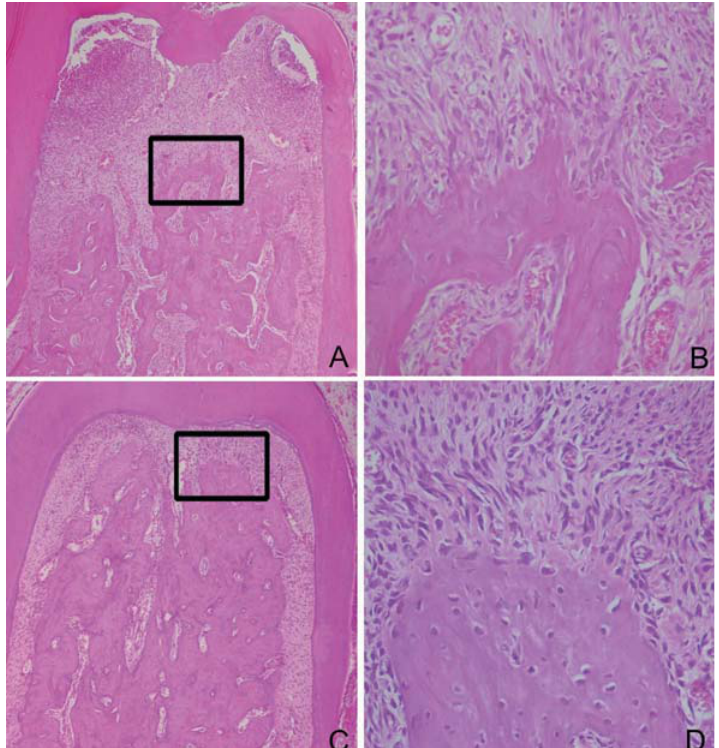
Figure 2- (cid:2)(cid:3)(cid:4)(cid:5)(cid:6)(cid:5)(cid:7)(cid:8)(cid:9)(cid:10)(cid:5)(cid:11)(cid:10)(cid:12)(cid:13)(cid:4)(cid:2)(cid:8)(cid:14)(cid:14)(cid:15)(cid:16)(cid:6)(cid:10)(cid:12)(cid:6)(cid:8)(cid:17)(cid:11)(cid:2)(cid:18)(cid:5)(cid:17)(cid:19)(cid:2)(cid:14)(cid:5)(cid:16)(cid:16)(cid:2)(cid:12)(cid:10)(cid:19)(cid:12)(cid:2)(cid:8)(cid:17)(cid:2)(cid:6)(cid:4)(cid:19)(cid:2)(cid:20)(cid:15)(cid:10)(cid:9)(cid:12)(cid:6)(cid:8)(cid:5)(cid:17)(cid:2)(cid:10)(cid:19)(cid:11)(cid:8)(cid:5)(cid:17)(cid:2)(cid:5)(cid:20)(cid:2)(cid:7)(cid:12)(cid:17)(cid:21)(cid:8)(cid:18)(cid:15)(cid:14)(cid:12)(cid:10)(cid:2)(cid:22)(cid:10)(cid:16)(cid:6)(cid:2)(cid:7)(cid:5)(cid:14)(cid:12)(cid:10)(cid:2)(cid:8)(cid:17)(cid:2)(cid:6)(cid:4)(cid:19)(cid:2)(cid:8)(cid:17)(cid:8)(cid:6)(cid:8)(cid:12)(cid:14)(cid:2)(cid:13)(cid:19)(cid:10)(cid:8)(cid:5)(cid:21)(cid:16)(cid:2) (cid:12)(cid:17)(cid:21)(cid:2)(cid:8)(cid:17)(cid:2)(cid:6)(cid:4)(cid:19)(cid:2)(cid:21)(cid:8)(cid:20)(cid:20)(cid:19)(cid:10)(cid:19)(cid:17)(cid:6)(cid:2)(cid:23)(cid:10)(cid:5)(cid:15)(cid:13)(cid:16)(cid:2)(cid:24)(cid:25)(cid:2)(cid:12)(cid:17)(cid:21)(cid:2)(cid:26)(cid:27)(cid:28)(cid:2)(cid:24)(cid:29)(cid:27)(cid:2)(cid:25)(cid:2)(cid:23)(cid:10)(cid:5)(cid:15)(cid:13)(cid:2)(cid:30)(cid:2)(cid:31)!(cid:2)(cid:21)(cid:12)"(cid:16)(cid:2)(cid:30)(cid:2)(cid:7)(cid:8)(cid:21)(cid:21)(cid:14)(cid:19)(cid:2)(cid:6)(cid:4)(cid:8)(cid:10)(cid:21)(cid:2)(cid:8)(cid:17)(cid:6)(cid:5)(cid:2)(cid:6)(cid:4)(cid:19)(cid:2)(cid:20)(cid:15)(cid:10)(cid:9)(cid:12)(cid:6)(cid:8)(cid:5)(cid:17)(cid:2)(cid:10)(cid:19)(cid:11)(cid:8)(cid:5)(cid:17)(cid:2)(cid:24)#(cid:10)(cid:8)(cid:11)(cid:8)(cid:17)(cid:12)(cid:14)(cid:2)(cid:7)(cid:12)(cid:11)(cid:17)(cid:8)(cid:22)(cid:9)(cid:12)(cid:6)(cid:8)(cid:5)(cid:17)(cid:2) $%&’((cid:27)(cid:2)(cid:30)(cid:2))(cid:19)(cid:6)(cid:12)(cid:8)(cid:14)(cid:2)(cid:24)*(cid:27)(cid:2)+(cid:5)(cid:6)(cid:19)(cid:2)(cid:6)(cid:4)(cid:19)(cid:2)(cid:6)(cid:4)(cid:8)(cid:17)(cid:2)(cid:18)(cid:5)(cid:17)(cid:19)(cid:2)(cid:6)(cid:10)(cid:12)(cid:18)(cid:19)(cid:9)(cid:15)(cid:14)(cid:12)(cid:19)(cid:2)/(cid:8)(cid:6)(cid:4)(cid:2)(cid:10)(cid:19)(cid:16)(cid:5)(cid:10)(cid:13)(cid:6)(cid:8)(cid:5)(cid:17)(cid:2)(cid:12)(cid:9)(cid:6)(cid:8)4(cid:8)(cid:6)"(cid:2)(cid:6)(cid:8)(cid:16)(cid:16)(cid:15)(cid:19)(cid:2)(cid:24)#(cid:10)(cid:8)(cid:11)(cid:8)(cid:17)(cid:12)(cid:14)(cid:2)(cid:7)(cid:12)(cid:11)(cid:17)(cid:8)(cid:22)(cid:9)(cid:12)(cid:6)(cid:8)(cid:5)(cid:17)(cid:2)$5!(cid:27)6(cid:2)(cid:24)(cid:25)(cid:27)(cid:2)(cid:26)(cid:2)(cid:23)(cid:10)(cid:5)(cid:15)(cid:13)(cid:2)9(cid:2)(cid:31)!(cid:2) (cid:21)(cid:12)"(cid:16)(cid:2)(cid:30)(cid:2)(cid:9)(cid:5)(cid:10)(cid:5)(cid:17)(cid:12)(cid:10)"(cid:2)(cid:6)(cid:4)(cid:8)(cid:10)(cid:21)(cid:2)(cid:8)(cid:17)(cid:6)(cid:5)(cid:2)(cid:6)(cid:4)(cid:19)(cid:2)(cid:20)(cid:15)(cid:10)(cid:9)(cid:12)(cid:6)(cid:8)(cid:5)(cid:17)(cid:2)(cid:10)(cid:19)(cid:11)(cid:8)(cid:5)(cid:17)(cid:2)(cid:24)#(cid:10)(cid:8)(cid:11)(cid:8)(cid:17)(cid:12)(cid:14)(cid:2)(cid:7)(cid:12)(cid:11)(cid:17)(cid:8)(cid:22)(cid:9)(cid:12)(cid:6)(cid:8)(cid:5)(cid:17)(cid:2)$%&’((cid:27)(cid:2)(cid:30)(cid:2))(cid:19)(cid:6)(cid:12)(cid:8)(cid:14)(cid:2)(cid:24))(cid:27)(cid:2)+(cid:5)(cid:6)(cid:19)(cid:2)(cid:6)(cid:4)(cid:8)(cid:9);(cid:2)(cid:18)(cid:5)(cid:17)(cid:19)(cid:2)(cid:6)(cid:10)(cid:12)(cid:18)(cid:19)(cid:9)(cid:15)(cid:14)(cid:12)(cid:19)(cid:2)/(cid:8)(cid:6)(cid:4)(cid:5)(cid:15)(cid:6)(cid:2)